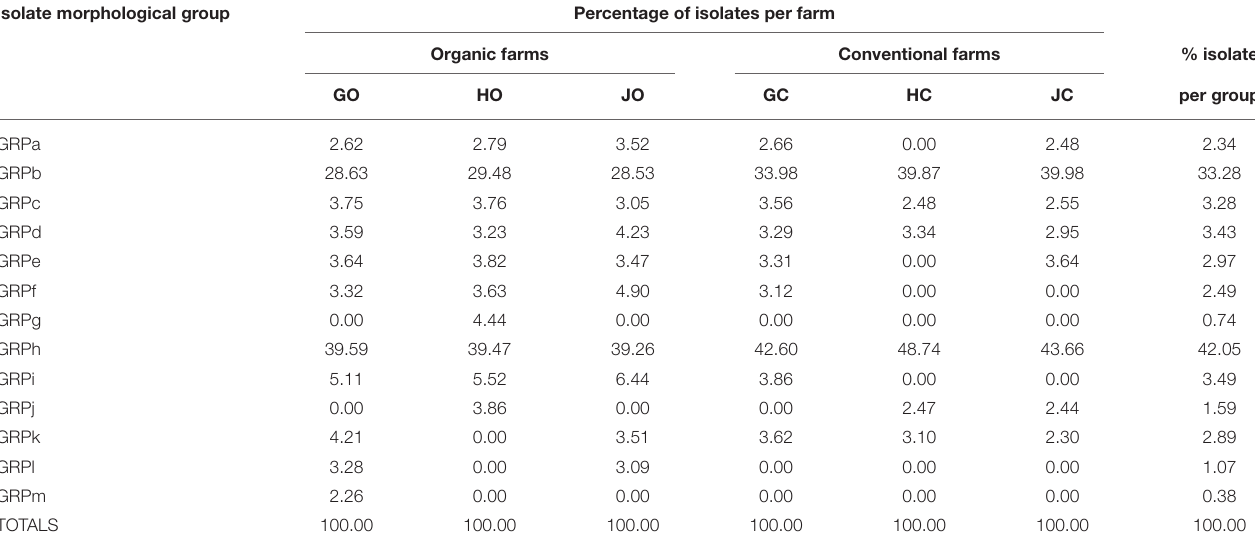
TABLE 4 | Percentage abundance of bradyrhizobia isolates obtained from soybean nodules grown in organic and conventional farms. Isolate morphological